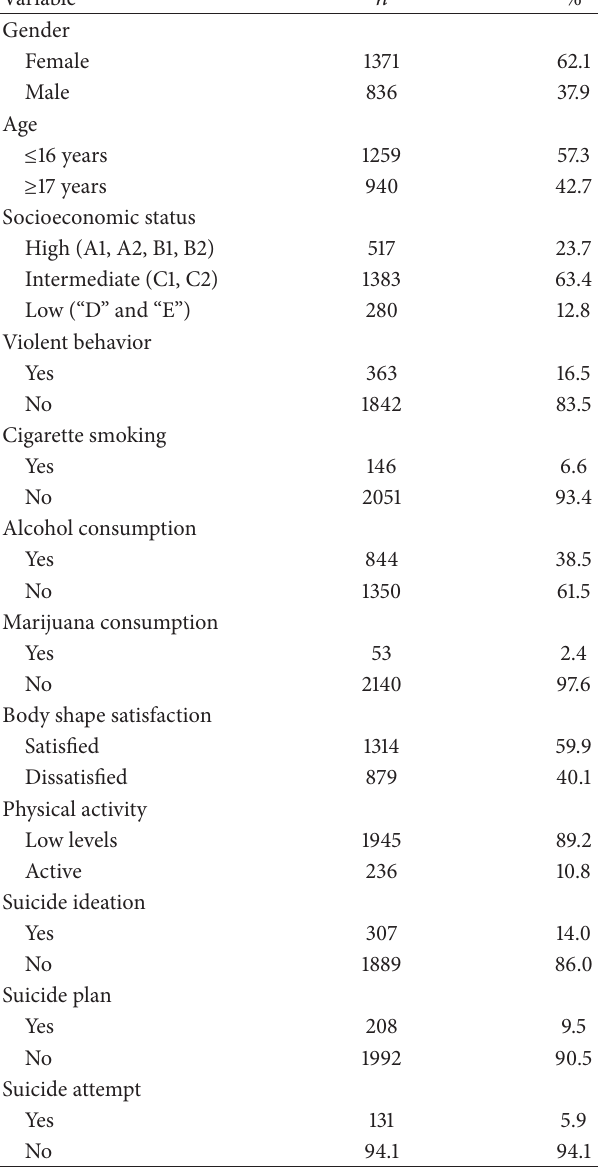
Table 2: Sociodemographic characterization and prevalence of risk behaviors among adolescents in Northeastern Brazil, 𝑛 =